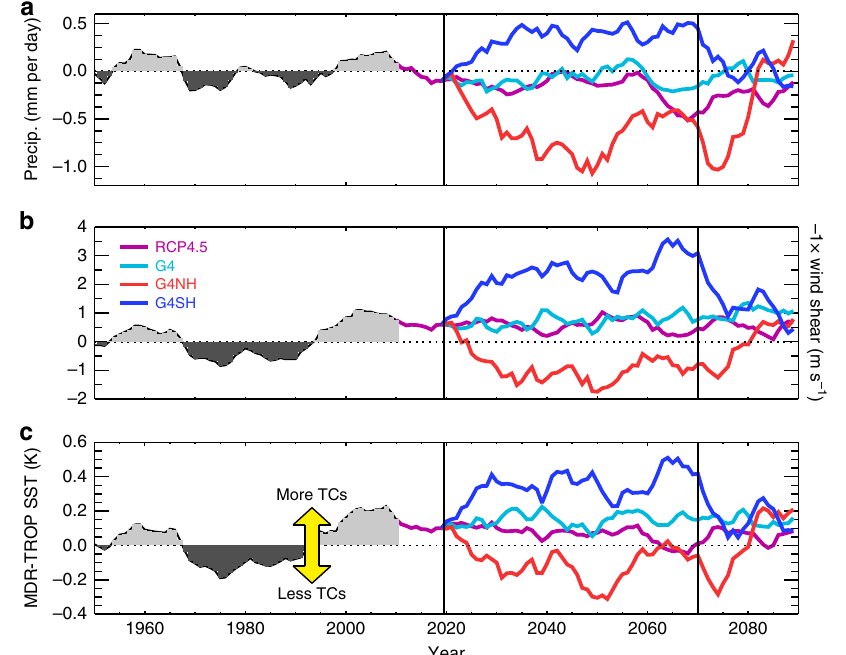
Fig. 5 Modelled tropical cyclone-related climate indices. a June – November (JJASON) precipitation anomaly (relative to 1950 – 2000) averaged over the hurricane main development region (MDR) (5° – 20°N, 15° – 85°W). b The same as a but for inverse vertical zonal-wind shear. c The same as a but for relative SST. G4 refers to a global SAI scenario, G4NH refers to a northern hemisphere SAI scenario, and G4SH refers to a southern hemisphere SAI scenario. Vertical lines at years 2020 and 2070 indicate the start and cessation of solar geoengineering,